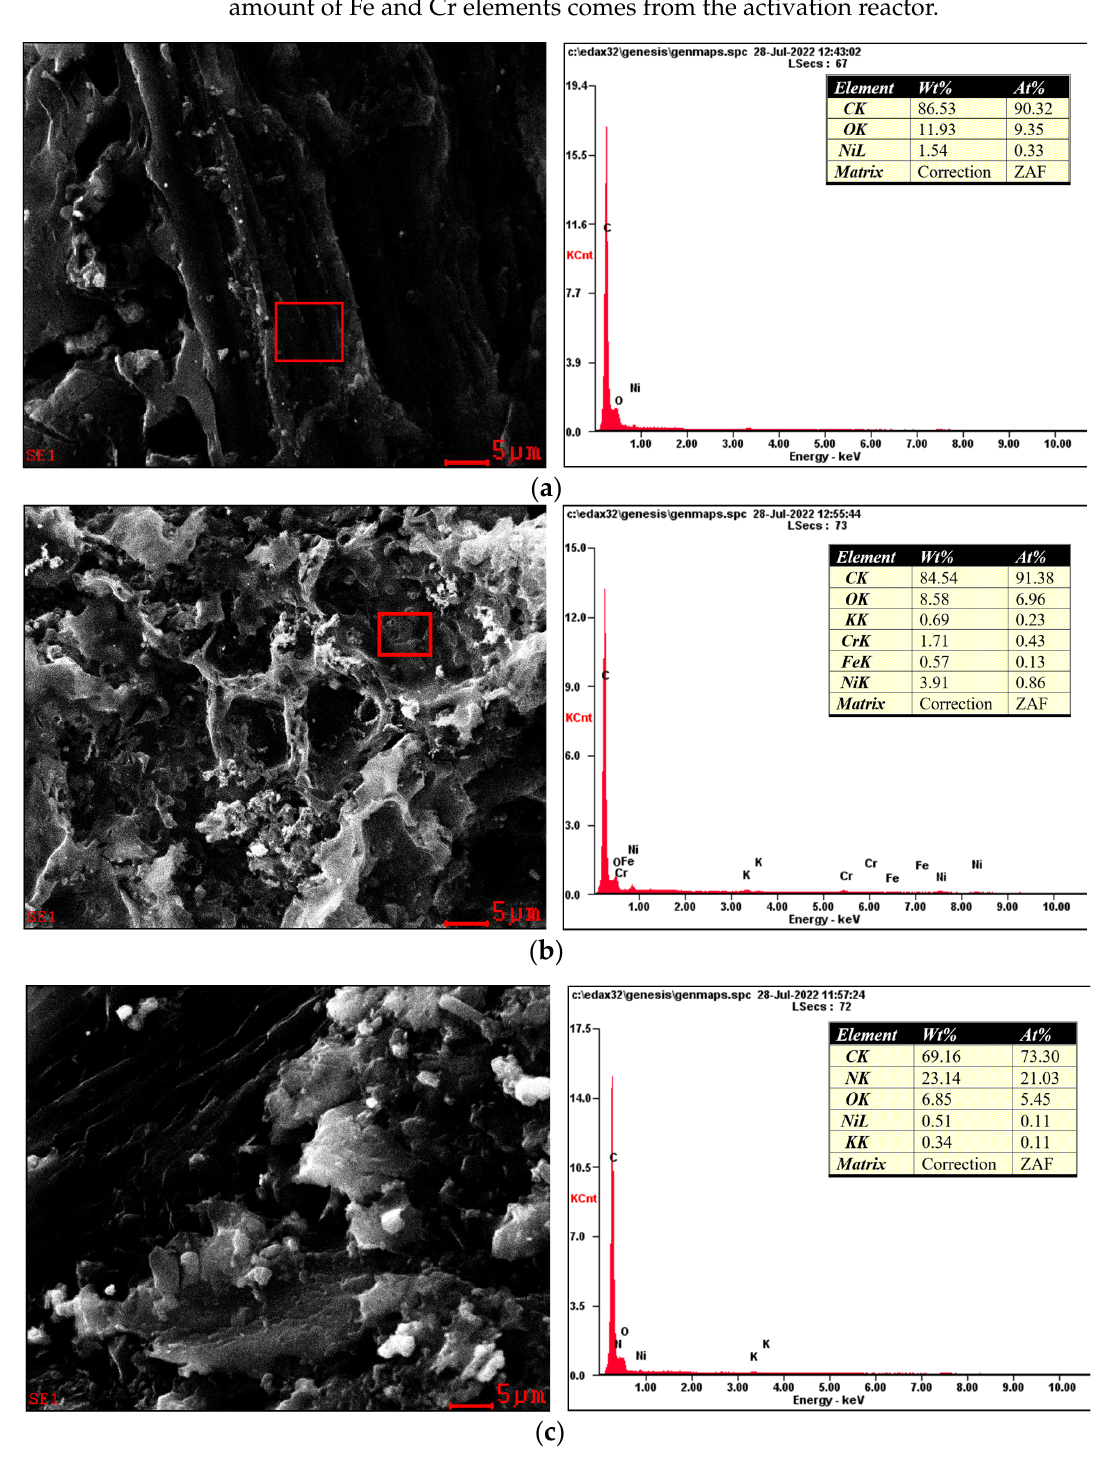
Figure 2. Scanning electron microscopy with energy-dispersive X-ray spectroscopy analysis results taken from different locations (red squares for figure ( a , b ) and the entire captured area for figure ( c )) for the sample WS-dAC/NiO-0.005.